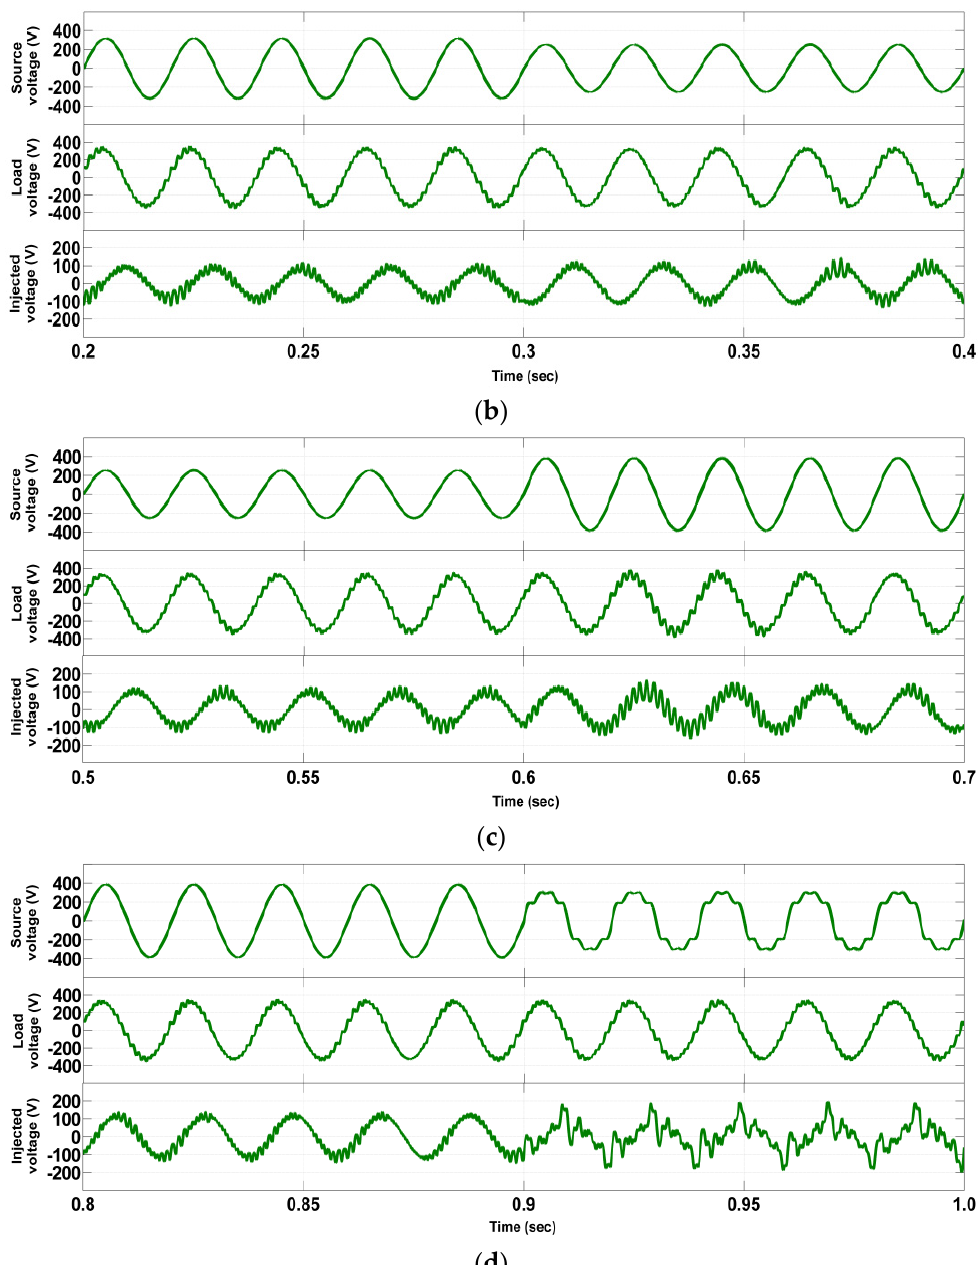
Figure 4. Simulation results with composite load (linear and non-linear): source voltage, load voltage and series injected voltage (top to bottom) at ( a ) 0–1.2 s, ( b ) 0.2–0.4 s, ( c ) 0.5–0.7 s and ( d ) 0.8–1.0 s.